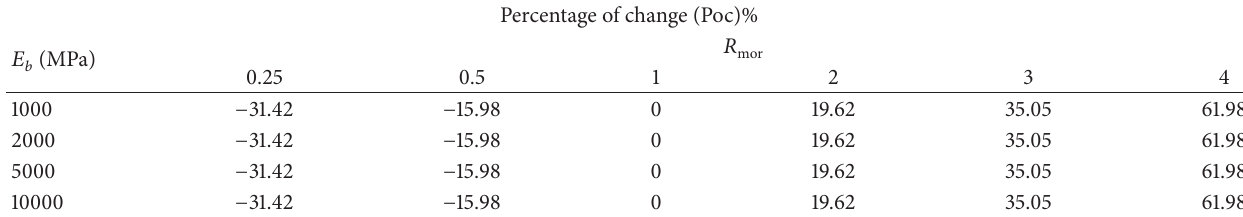
Table 4: Percentage of change of simulation.